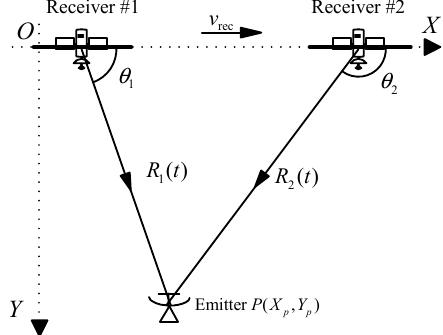
Figure 1. The geometry of two receivers and an emitter.